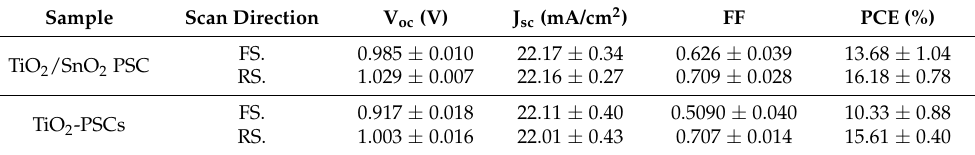
Figure 6. Statistical distribution of TiO 2 and TiO 2 /SnO 2 based PSCs (10 devices). ( a ) V OC , ( b ) J SC , ( c ) FF and ( d ) PCE. Table 2. Average photovoltaics parameters of PSCs based on TiO 2 and TiO 2 /SnO 2 ETLs.